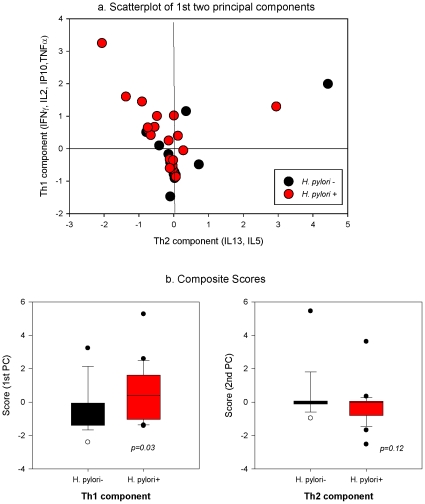
Concurrent H. pylori infection is associated with Th1+/Th2− type profile.
A. Scatterplot of principal component scores for 40 adults with latent TB infection (either QuantiFERON-TB GOLD® or TST positive) obtained after linear transformation with eigenvector coefficients. Vertical-axis: 1st component (eigenvalue 2.6), which is largely explained by IFN-γ and IL-2, and to a lesser extent IP-10 and TNF-α. Horizontal axis: 2nd PC (eigenvalue 1.5), characterized by loading of IL-13 and IL-5 and negative correlations with the four inflammatory markers. Red circles: 23 H. pylori infected; Black circles: 17 H. pylori seronegative. Reference lines denote quadrants centered on 0; B. comparison of median composite Th1 and Th2 component scores; p-values computed by Wilcoxon's 2-sided median test.